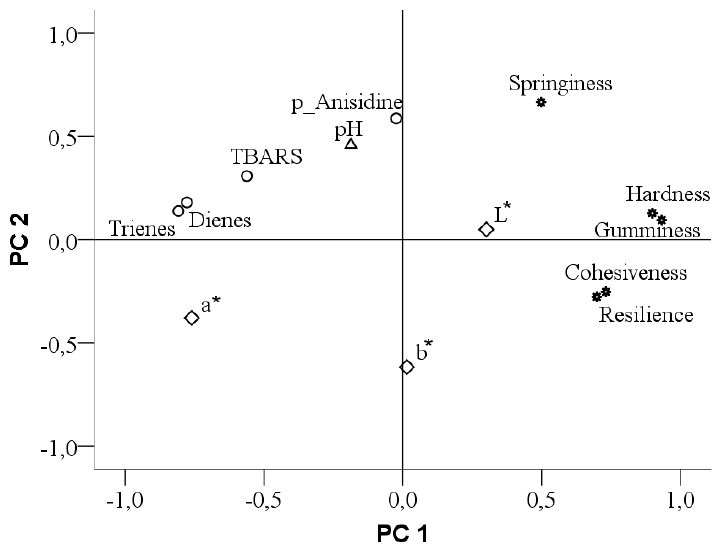
Figure 1. Loading plot of first two principal components based on L*, a*, b* color parameters, pH-value, textural parameters and lipid peroxidation parameters.